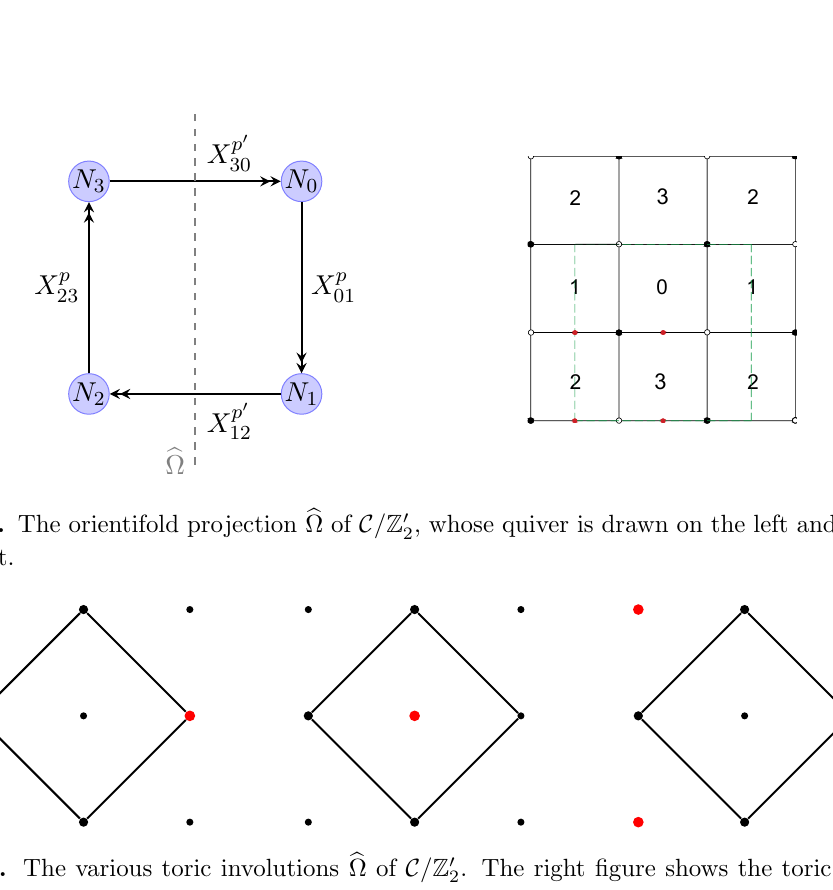
Figure 19. The various toric involutions b (cid:10) of C = Z 0 with a non-compact (cid:10)7, in the center a compact (cid:10)7 and on the right a (cid:10)3.